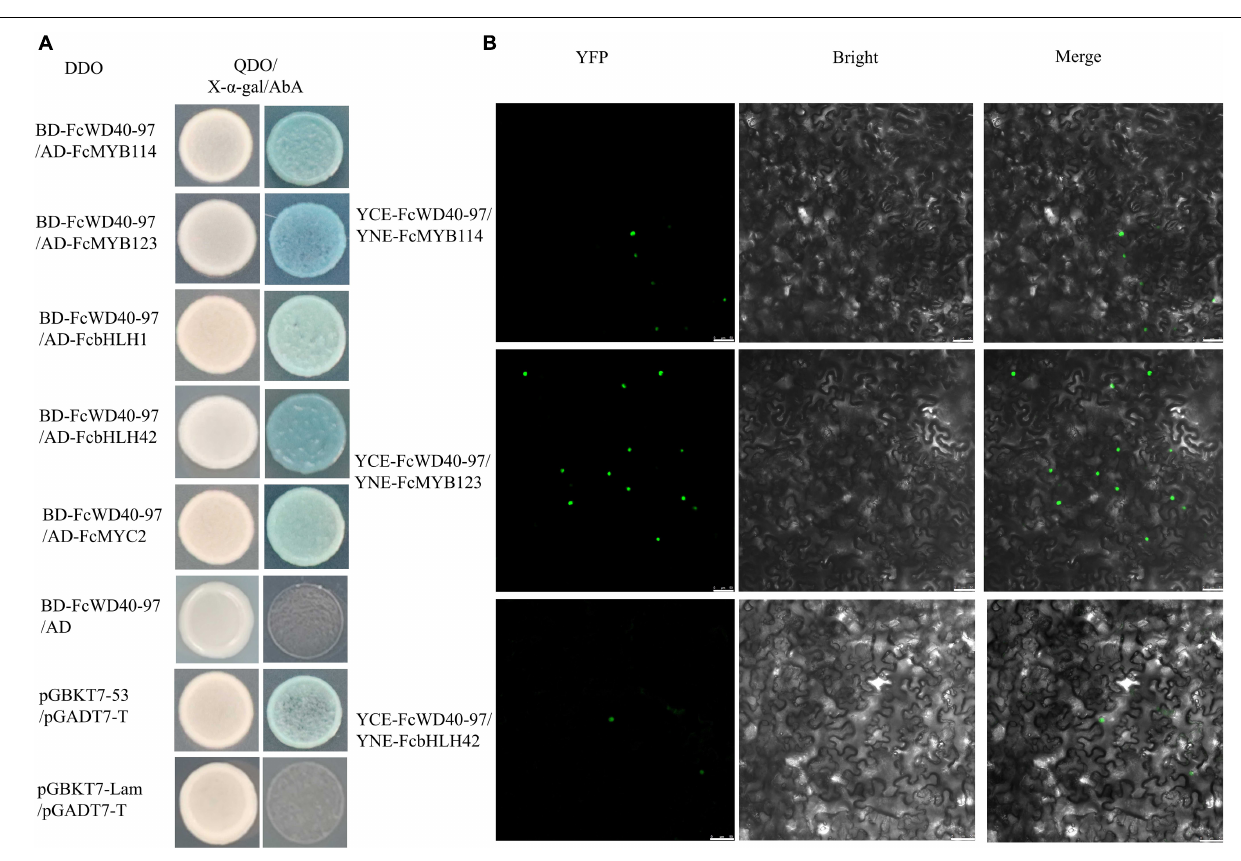
a deduced amino acid sequence that had 79.88% similarity to AtTTG1 (Li et al., 2014), 88.01 and 87.94% to apple TTG1 and peach WD40, respectively (An et al., 2012; Cui et al., 2021), 85.67,